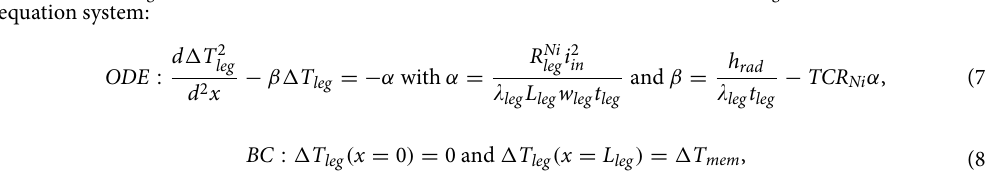
175 µ A , correspond- =